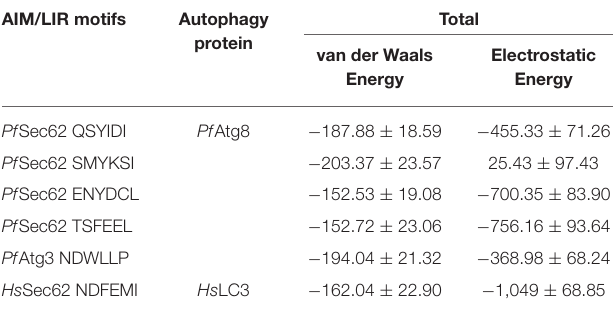
± 71.77, − 177.94 ± 97.46, − 852.89 ± 76.03 and − 908.88 ± 90.58 TABLE 2 | Non-covalent bond interaction energy of the AIM/LIR - Pf Atg8/ Hs LC3